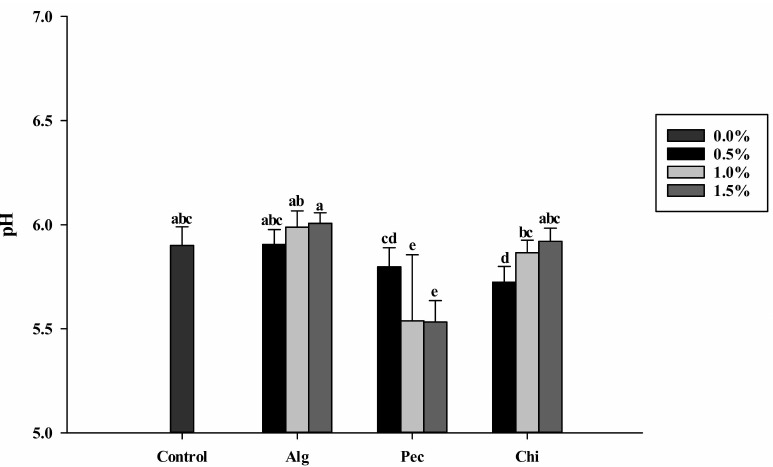
Figure 1. pH values of biscuits made of sodium alginate, pectin and chitosan additions in different concentrations. a, b, c, d, e: indicate statistically significant difference ( p < 0.05) among treatments ( n = 3). Alg: Sodium alginate; Pec: Pectin; Chi: